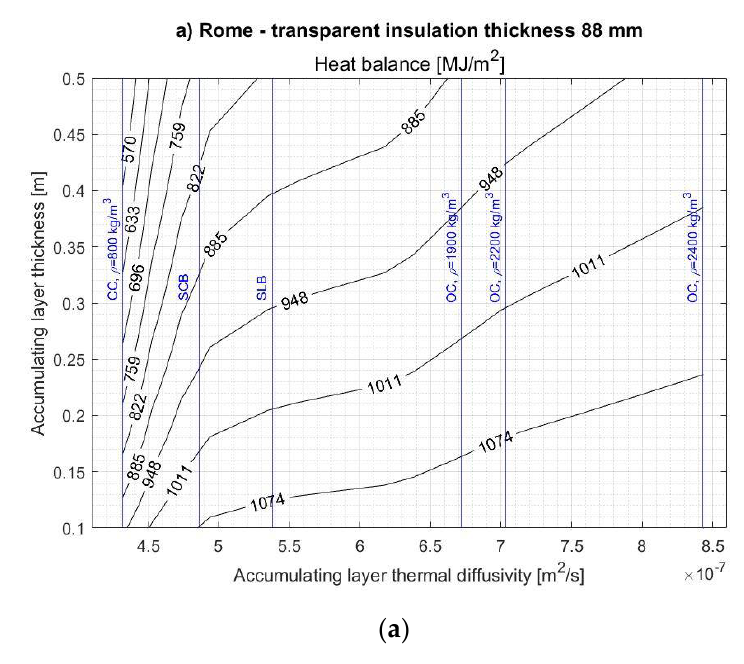
Figure A11. Cont